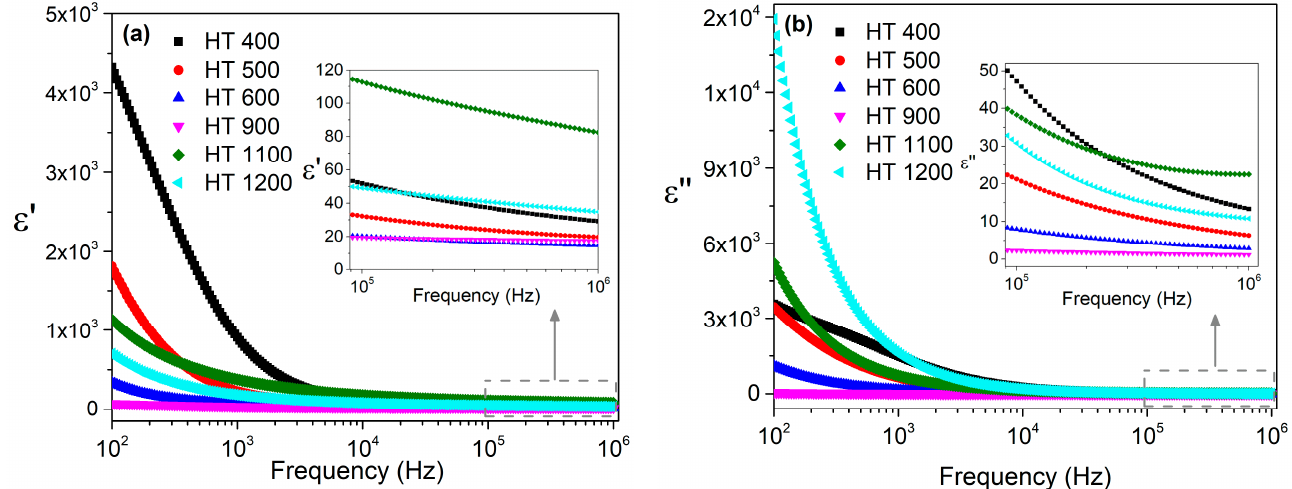
Figure 10. Frequency dependence of the ( a ) dielectric constants and ( b ) dielectric losses at room temperature for the samples prepared via the colloidal gel method.